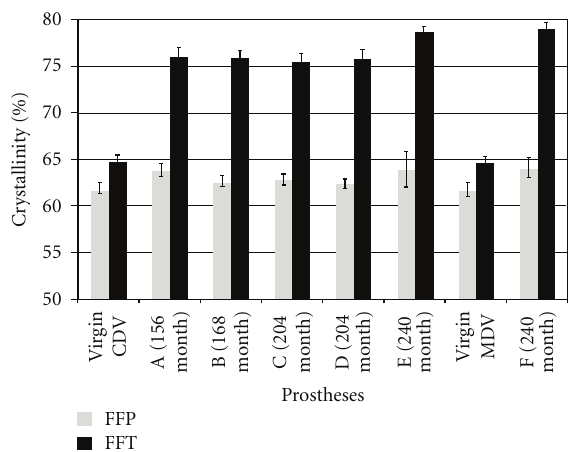
Figure 9: percent of crystallinity value for texturized and flat yarn.